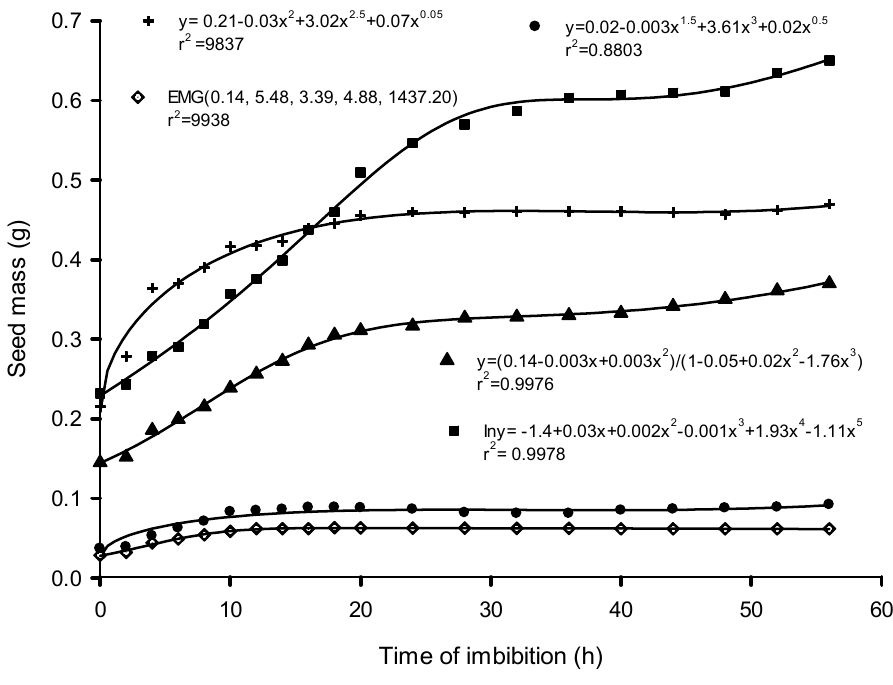
Figure 2. Changes in the seed mass of Bolusanthus speciosus ( • ), Combretum erythrophyllum ( ♦ ), Erythrina caffra ( ▲ ), Pisum sativum ( ■ ), and Cucurbita pepo (+) as the species imbibed water.